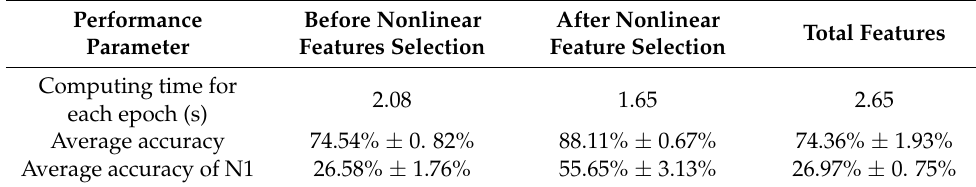
Table 6. The performance of different